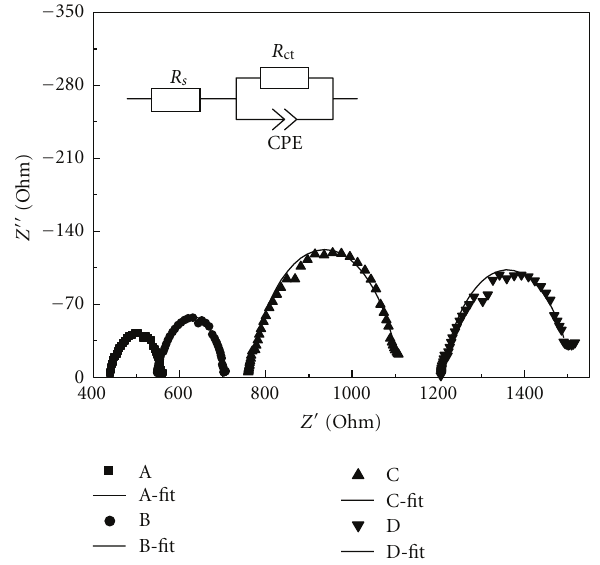
Figure 5: EIS and its equivalent circuit of solutions A ∼ D at 25 ◦ C. Solution component: (A) m(HEEDAI): m(MPII) = 1:9; (B) m(HEPI):m(MPII) = 1 :9; (C) m(HEEDAI):m(MPII) = 1:4; (D)